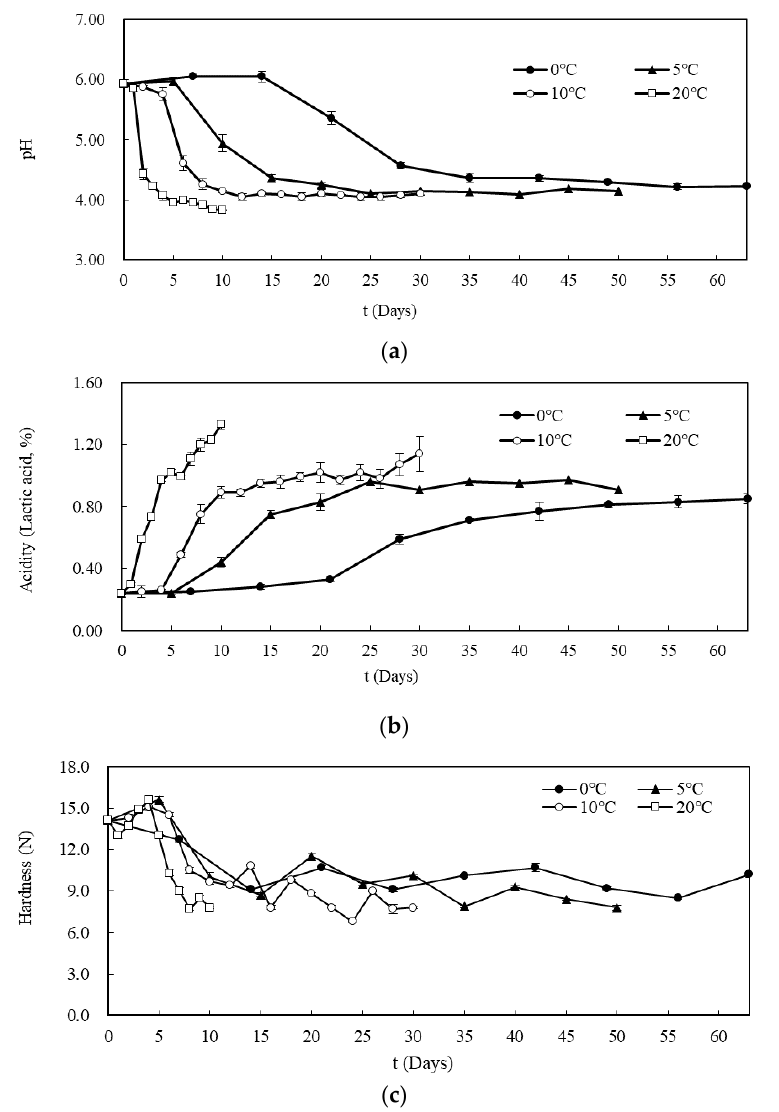
Figure 2. Changes in ( a ) pH, ( b ) acidity, and ( c ) hardness of Kimchi during fermentation at 0, 5, 10 and 20 °C.